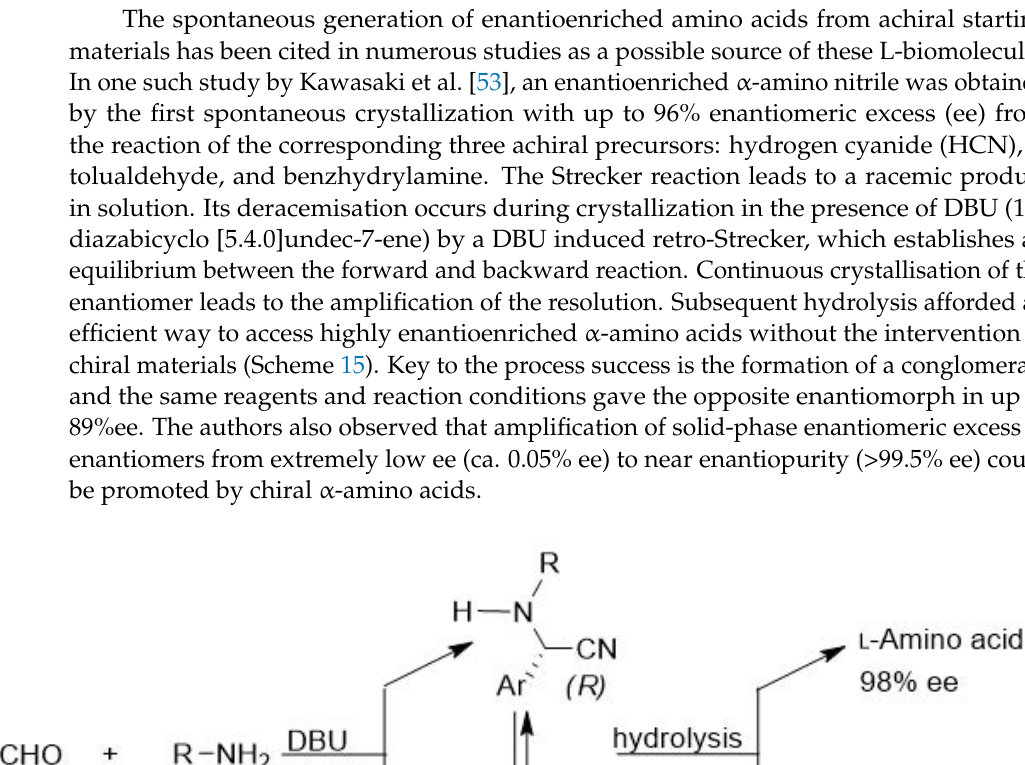
Scheme 14. Two-step one-pot asymmetric Strecker reaction.